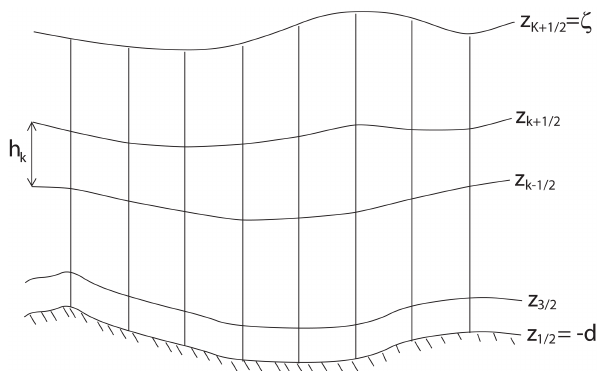
Figure 2. Vertical grid definition (sigma layers) (Zijlema and Stelling, 2005).